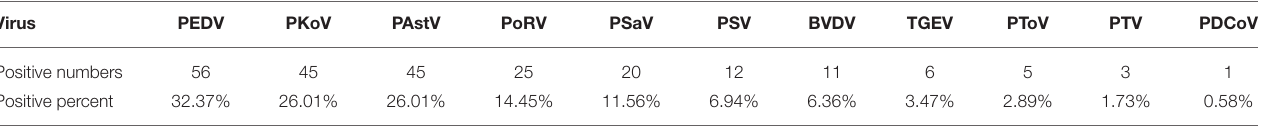
TABLE 3 | The detection of various pathogens from a longitudinal follow-up study in 2017. Virus